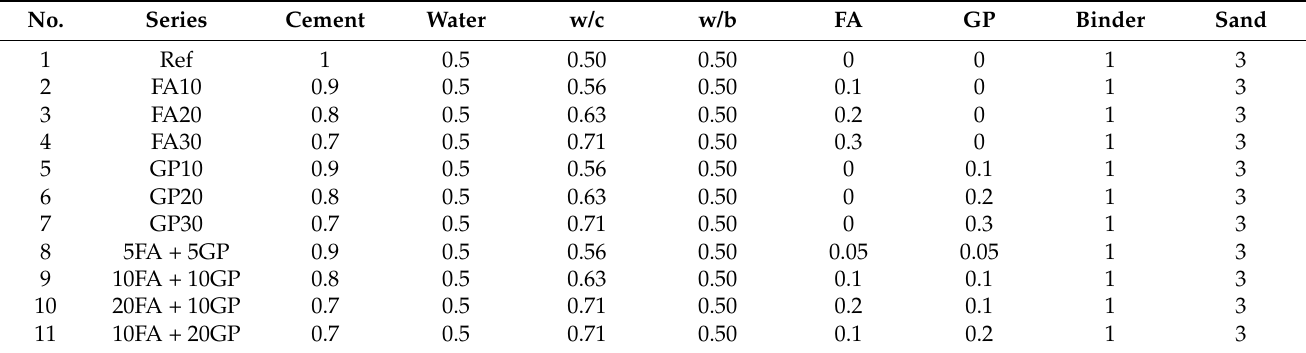
Figure 1. Chemical composition of ingredients used in the research. ( a ) Cement, ( b ) siliceous fly ash, and ( c ) granite powder. Table 1. The series compositions of the cementitious mortar mixes.